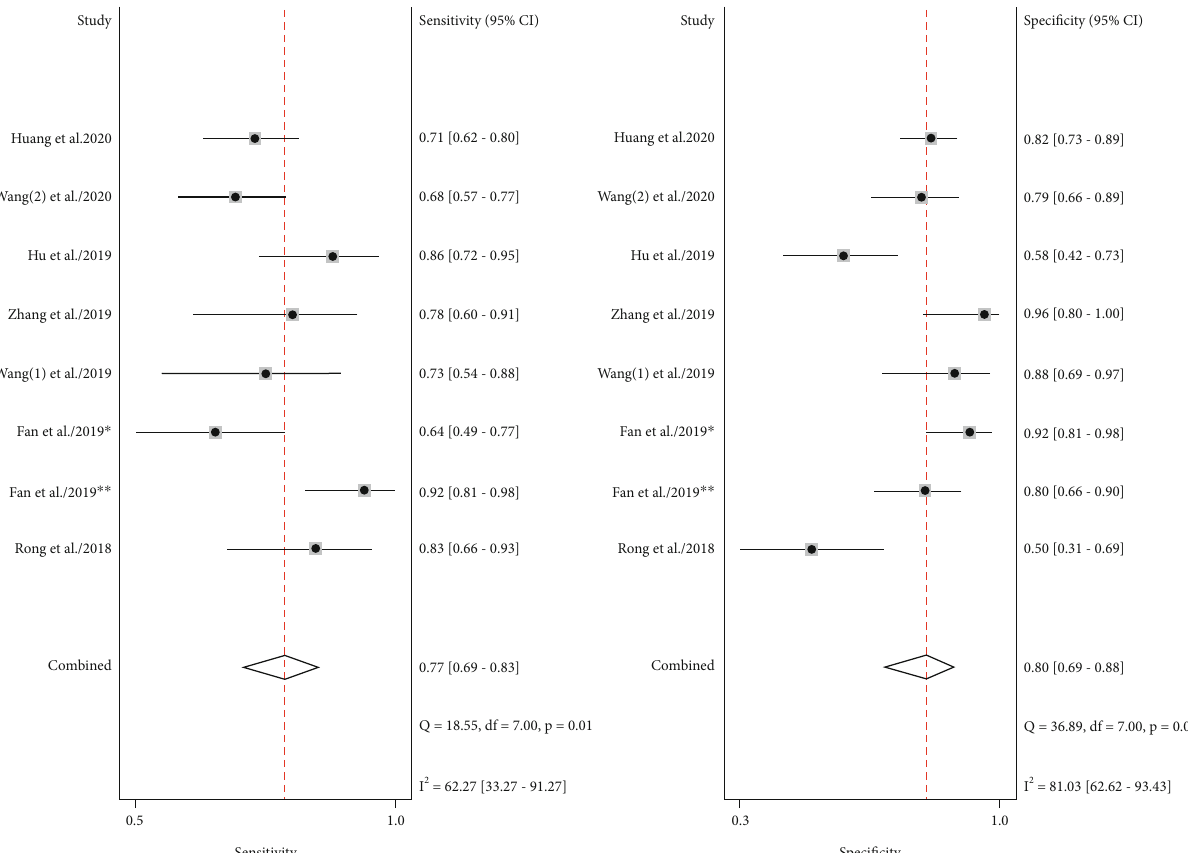
Figure 2: Forest plots of summary sensitivity and speci fi city to illustrate the diagnostic value of circRNAs for EC. circRNAs, circular RNAs; EC, esophageal